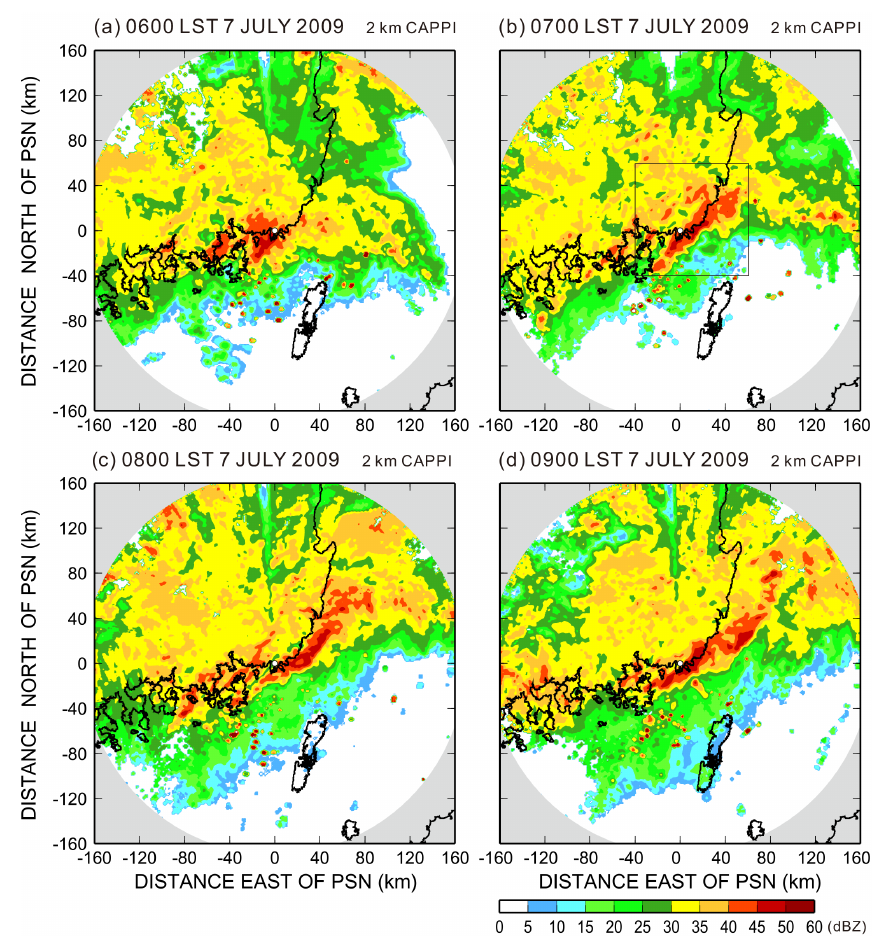
Figure 8. Horizontal section of radar reflectivity (dBZ, colour shading) at a height of 2km observed by PSN radar at hourly intervals from (a) 06:00 to (d) 09:00LST 7 July 2009. The box in (b) indicates the domain for Fig.